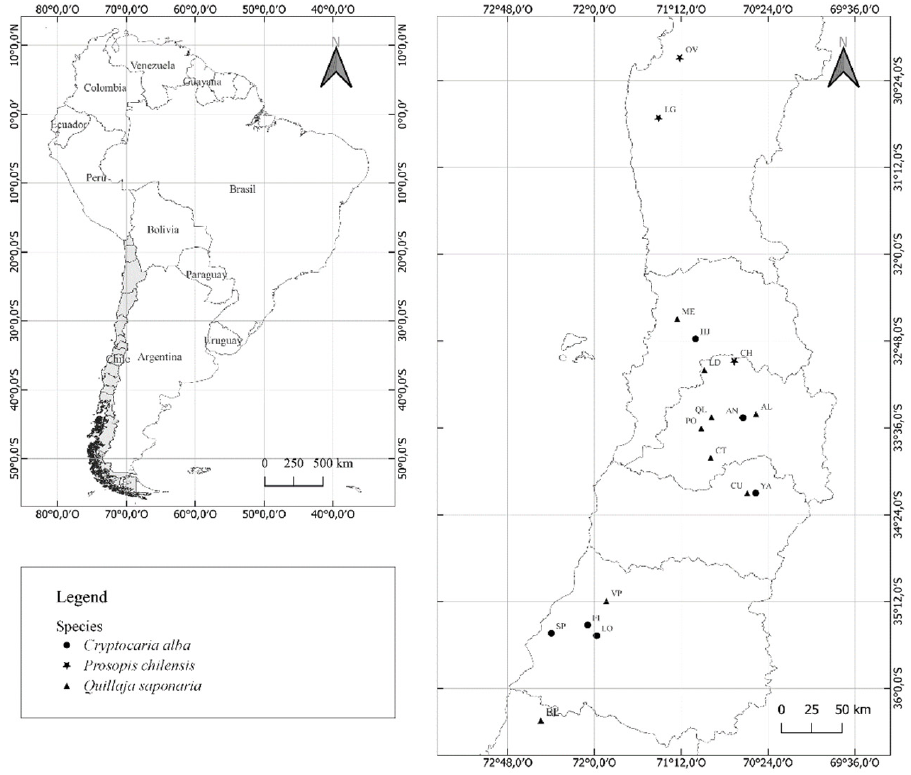
Figure 4. Seed collection sites (seed sources) for P. chilensis , Q. saponaria and C. alba throughout their natural distribution. P. chilensis : OV = Ovalle; LG = Chalinga and CH = Chacabuco. Q . saponaria : ME = El Melón; LD = La Dormida; AO = Cantalao; QL = Quebrada de la Plata; CT = Cantillana; PO = Pomaire; CU = Camino el Cobre; VP = Villa Prat and BL = Ñuble. C. alba : HJ = Hijuelas; AN = Antumapu; YA = Coya; FI = Infiernillo; SP = San Pedro and LO = Loncomilla.